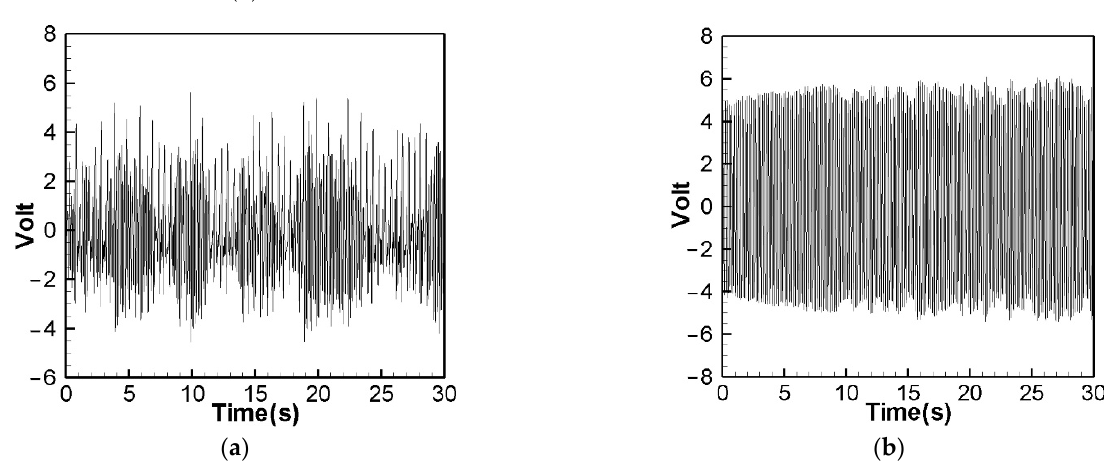
Figure 14. Theoretical voltage prediction for “linear” frequency excitation. ( a ) 1st mode, ( b ) 2nd mode.